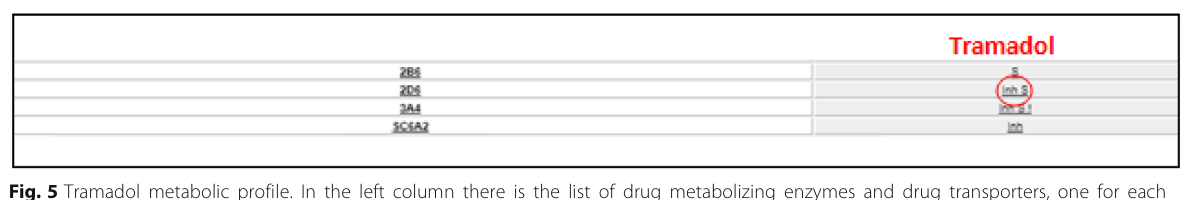
Fig. 5 Tramadol metabolic profile. In the left column there is the list of drug metabolizing enzymes and drug transporters, one for each row; in the right column relationship between corresponding transporter or enzyme of the row and tramadol: is indicated by the symbol ‘ S ’ for substrate and ‘ Inh ’ for inhibitor. Enzyme CYP2D6 is rimmed to emphasize its importance in tramadol ’ s metabolic destiny. Related page at the website